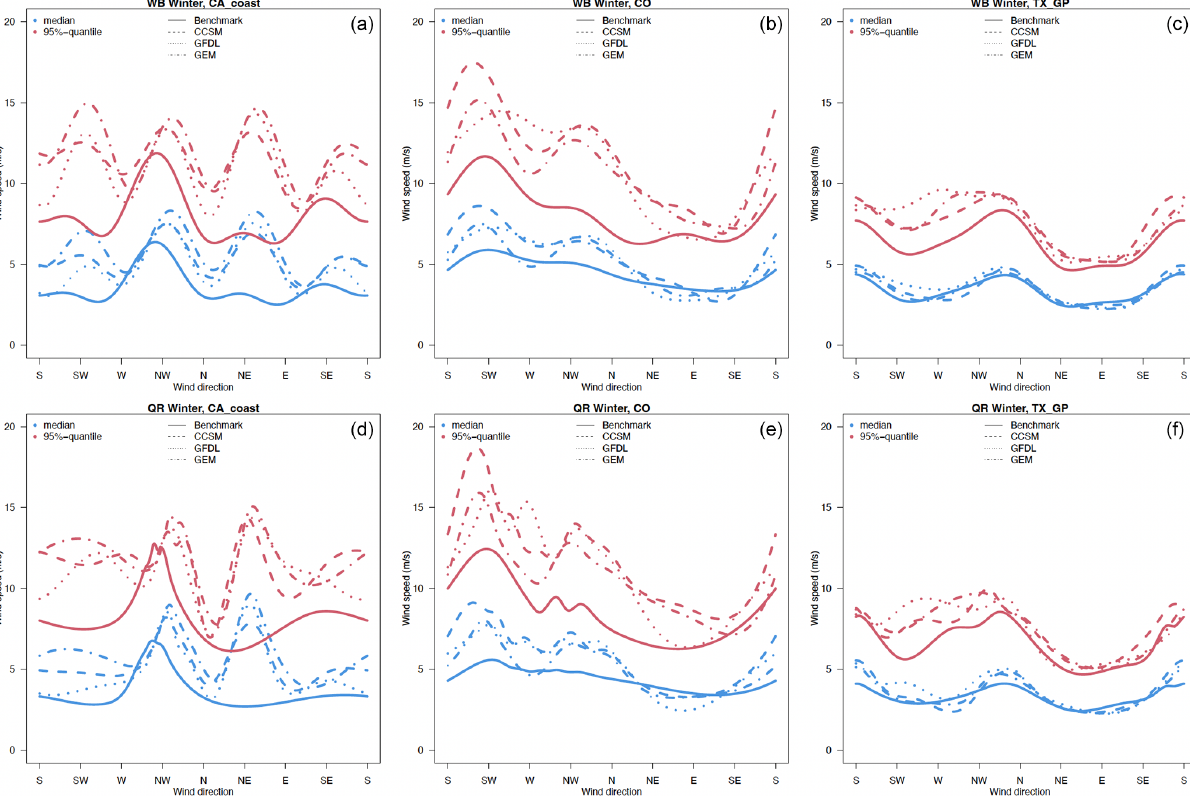
Figure 6. The 50th (blue) and 95th (red) quantiles of wind speed as a function of wind direction for the historical period in winter for offshore California (a, d) , Colorado (b, e) , and Texas-SGP (c, f) using the Weibull distribution regression model (a–c) and quantile regression model (d–f) . The different RCMs are shown with different types of dotted and dashed lines, while benchmark data are in solid lines (NARR for offshore and NLDAS for